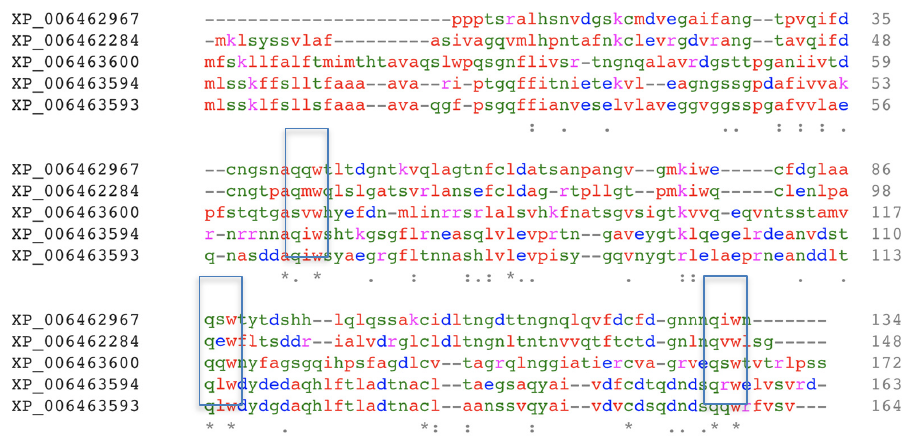
Figure 2. Alignment of amino acid sequences of the homologous putative Ricin B-like lectins [27]. The (Gln-x-Trp) 3 canonical sequence motifs of β -trefoil fold are highlighted in boxes. The protein annotations are according to the GenBank ID; the asterisk (*), colon (:), and period (.) signs indicate the identical, conserved, and similar amino acid residues, respectively.